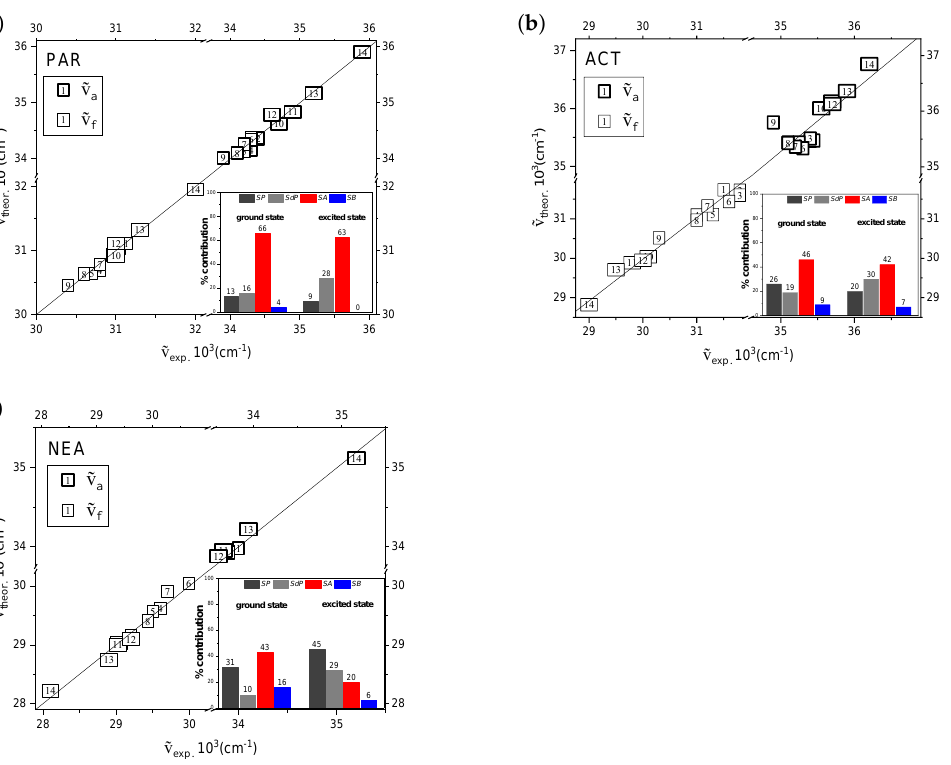
Figure 4. Position of the long-wavelength absorption and fluorescence bands of ( a ) PAR, ( b ) ACT, and ( c ) NEA obtained according to Catalán model (˜ ν theor ) versus the corresponding experimental a , f ˜ ν a and ˜ ν f values. The relative (percentage) contribution of non-specific and specific interactions is presented in the inset of Figure